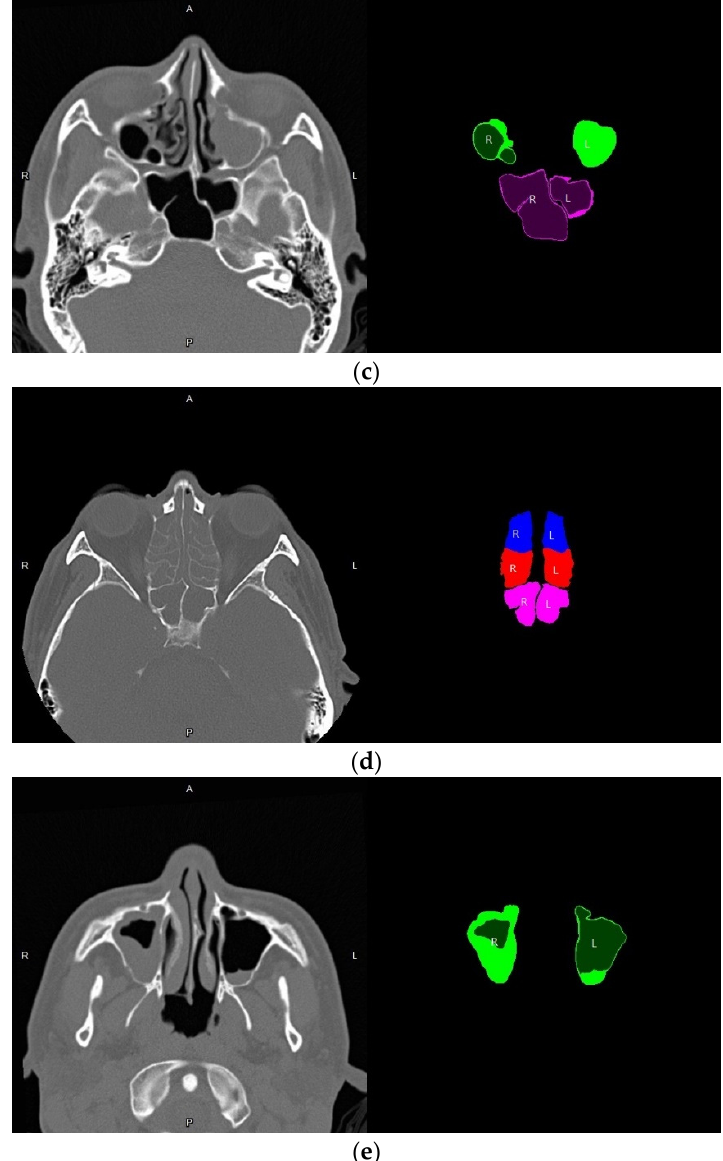
Figure 22. ( a – e ) are the final segmentation results from the system.